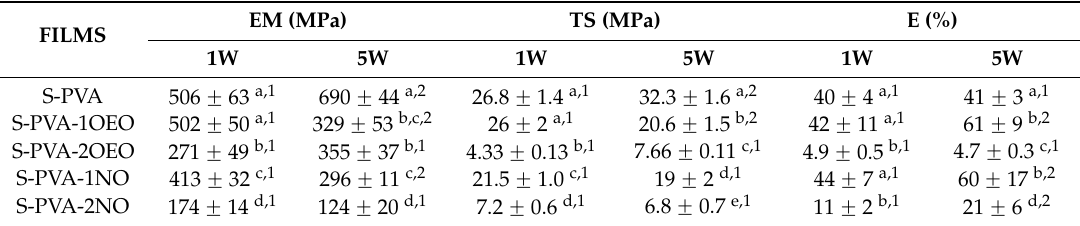
Table 3. Elastic modulus (EM, MPa), tensile strength (TS, MPa) and percentage of elongation (E, %) of blend control film and oil composite